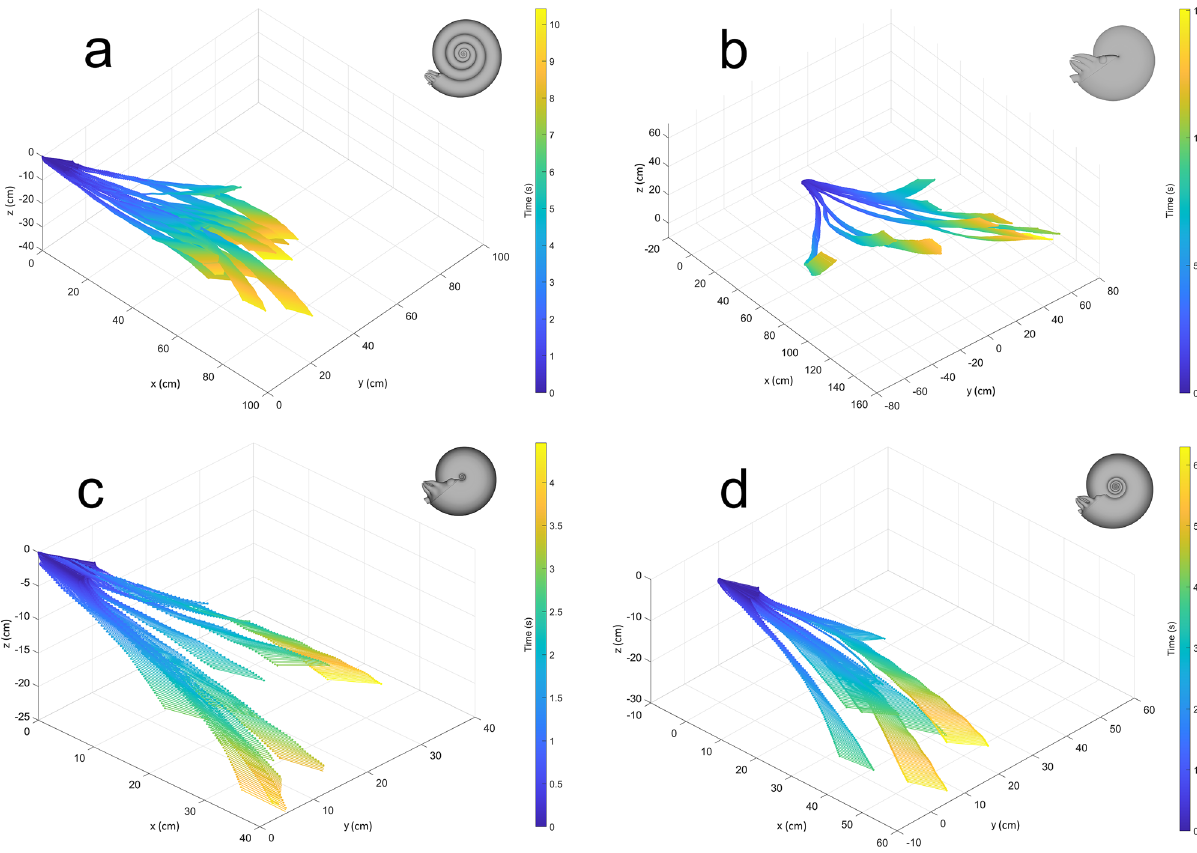
Figure 4. Three-dimensional positions of tracking points for each robot after initiating a single, one-second jet pulse. ( a ) Serpenticone, ( b ) oxycone, ( c ) sphaerocone, and ( d ) morphospace center. The times after initiating the motor are indicated by